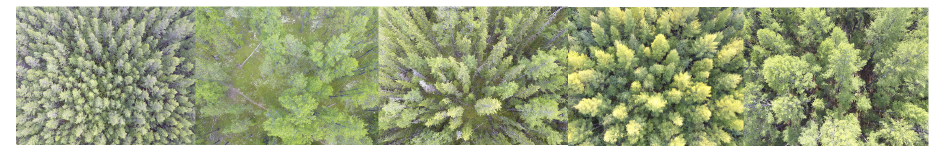
Figure 7. Examples of red–green–blue (RGB) images of plots from the selected unmanned aerial vehicle (UAV) flights in the following order: EN18063, EN18068, EN18074, EN18078, and EN18083.